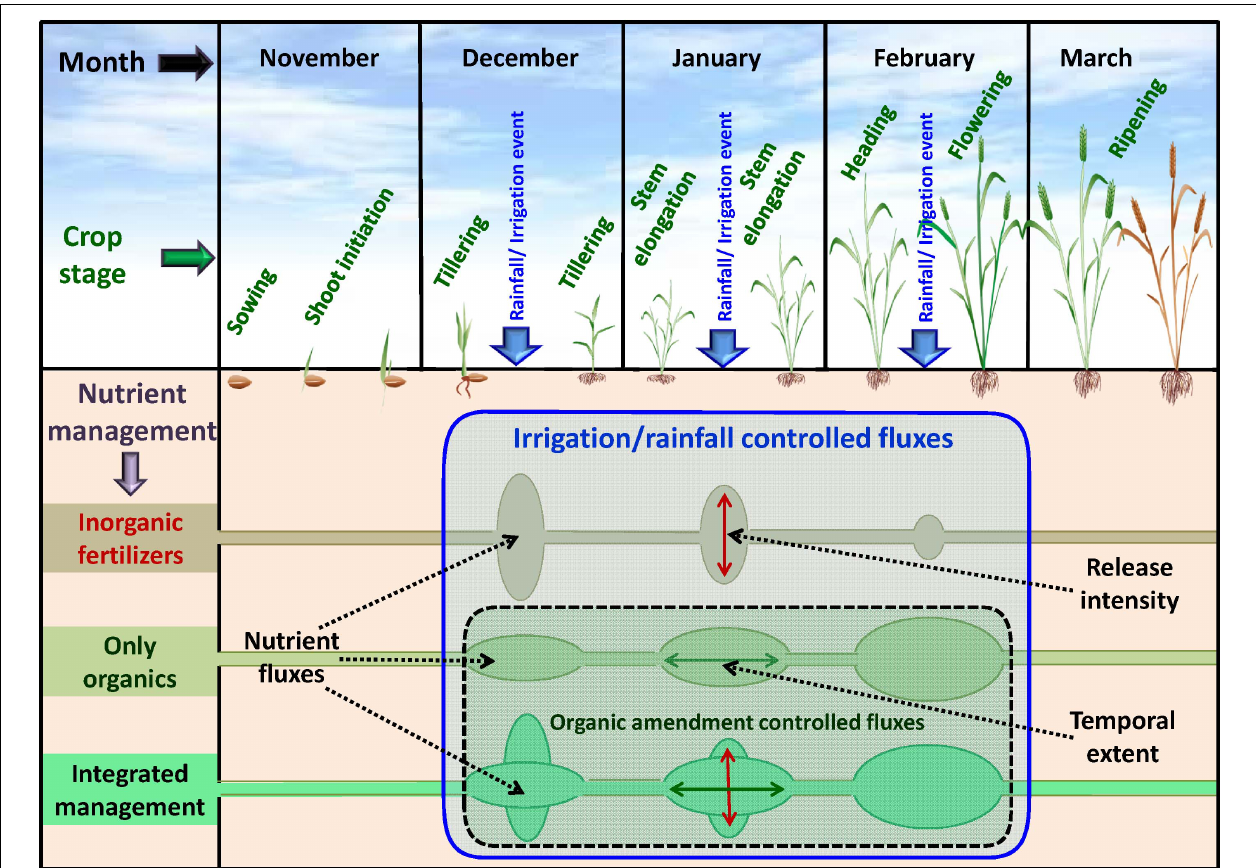
FIGURE 1 | General nitrogen (N) availability scenarios under organic, inorganic, and integrated fertilization during wheat ( Triticum aestivum ) growing period.